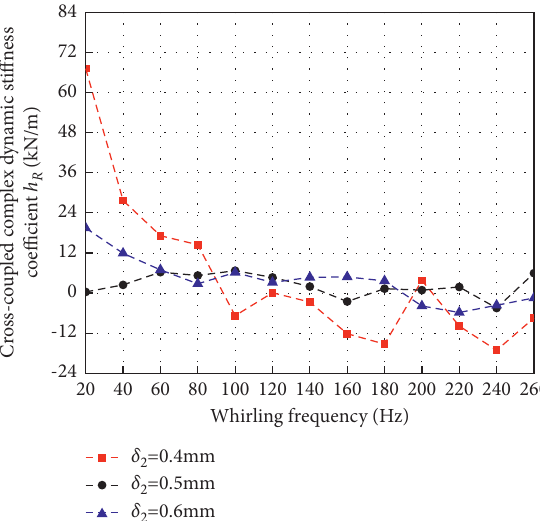
Figure 25: Cross-coupled complex dynamic stiffness coefficient vs. whirling